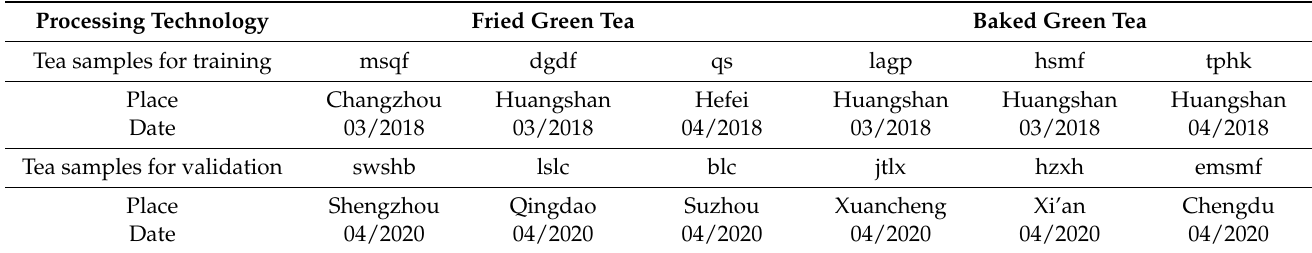
Table 1. Detailed information of green tea